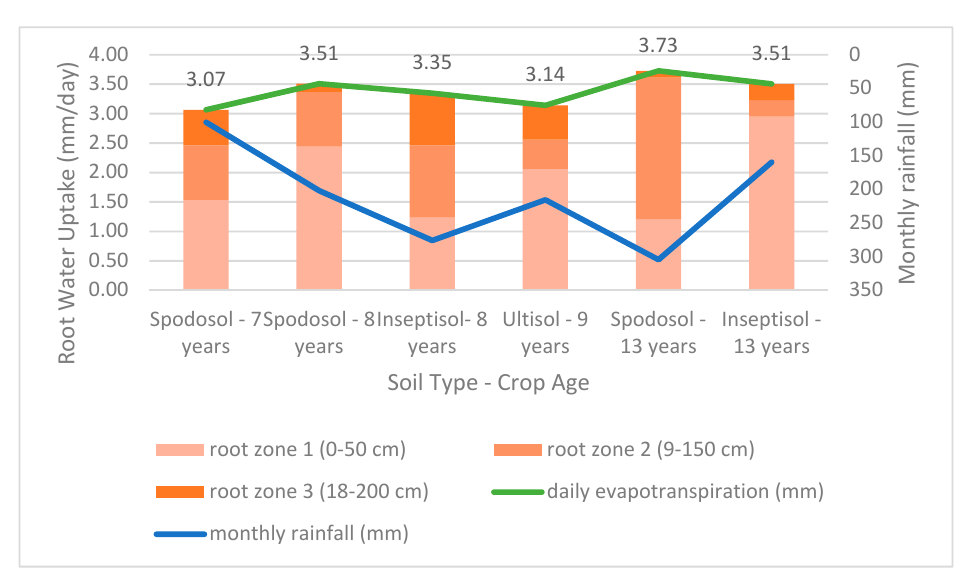
Figure 3. The distribution of root water uptake in oil palm root zone.